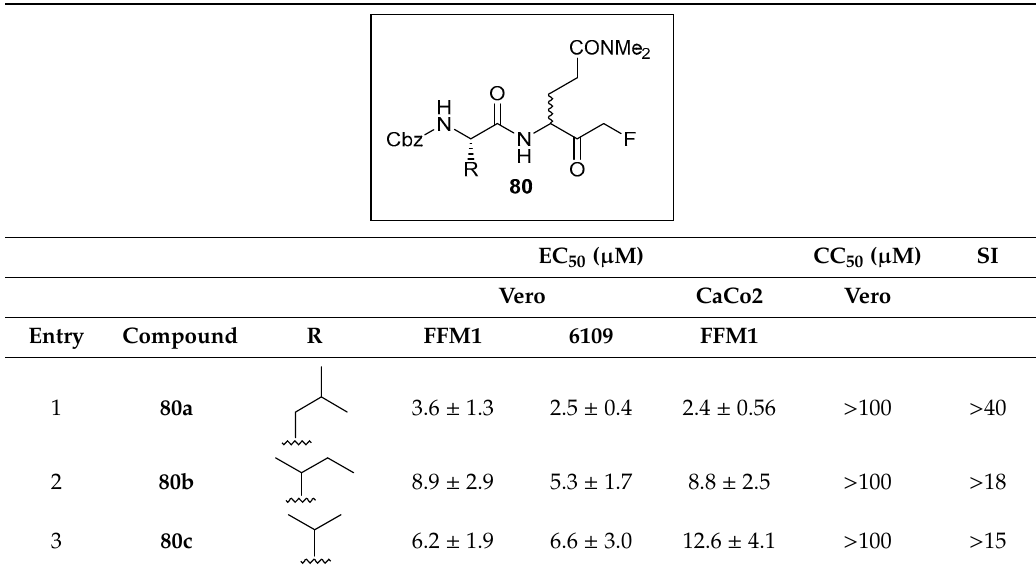
Figure 5. Structure of IR780-linker-Val-Ala-Glu(OMe)-FMK ( 81 ) [7].